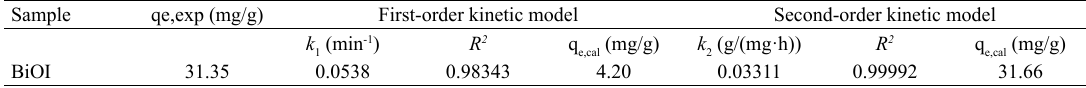
Table 3. Kinetic parameters for the adsorption of Cr(VI) onto BiOI sample Sample